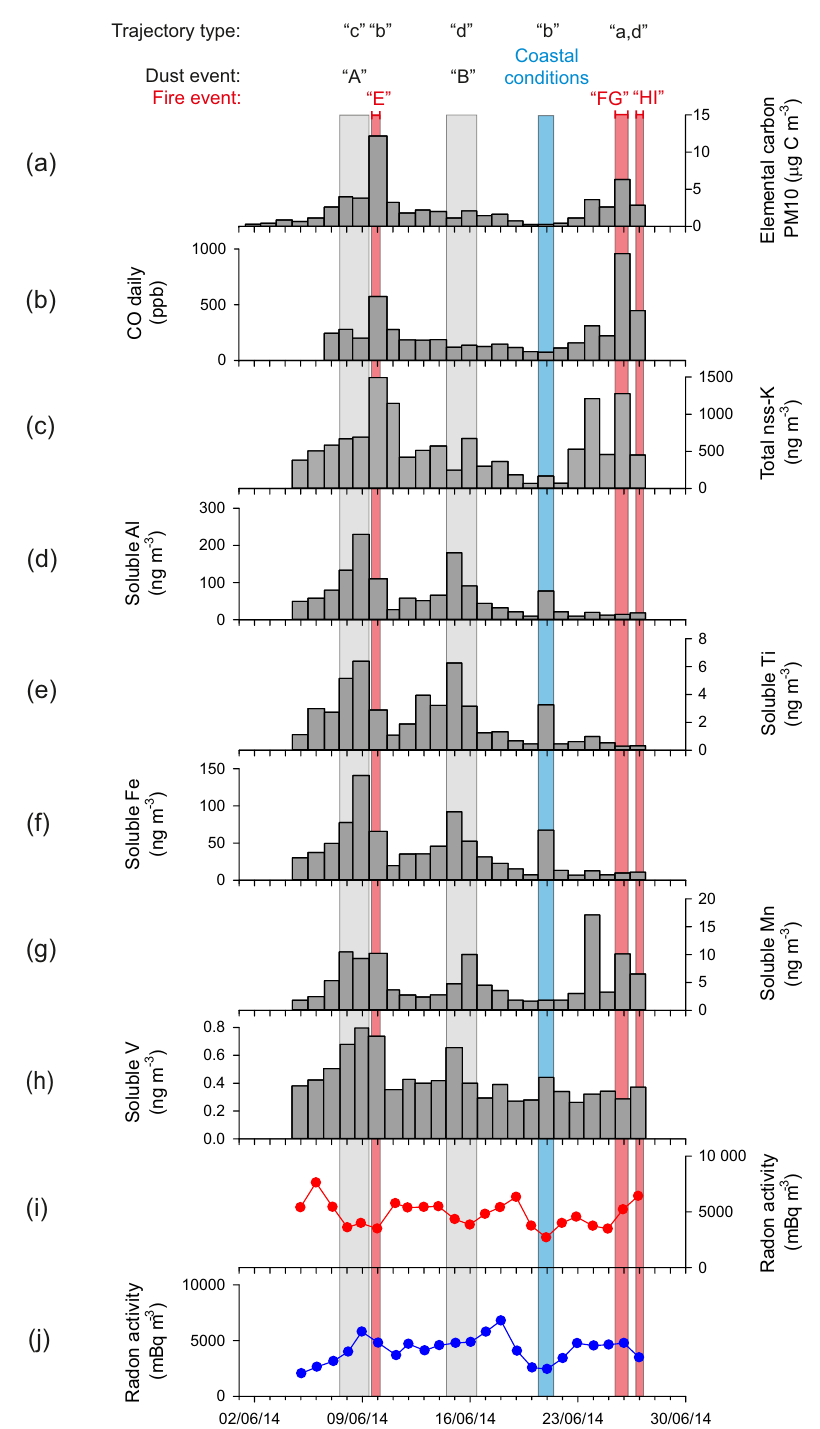
Figure 5. Soluble trace metal composition of daily aerosol samples influenced by dry season biomass burning at Gunn Point, northern Australia. Time series of (a) elemental carbon concentration; (b) carbon monoxide concentration; PM 10 trace element concentrations of (c) total nss-K, (d) soluble Al, (e) soluble Ti, (f) soluble Fe, (g) soluble Mn, and (h) soluble V; and (i) diurnal radon and (j) advective radon. Fire events, dust events and coastal conditions are highlighted. For trajectory types associated with these periods refer to Fig.